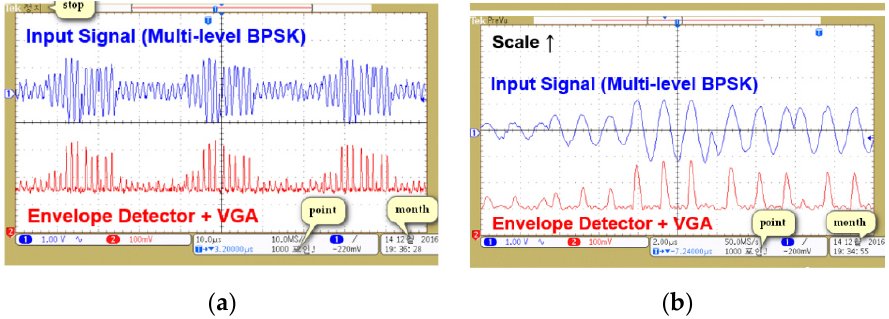
Figure 13. Measured ( a ) full-scale and ( b ) magnified waveforms of envelope detector and variable gain